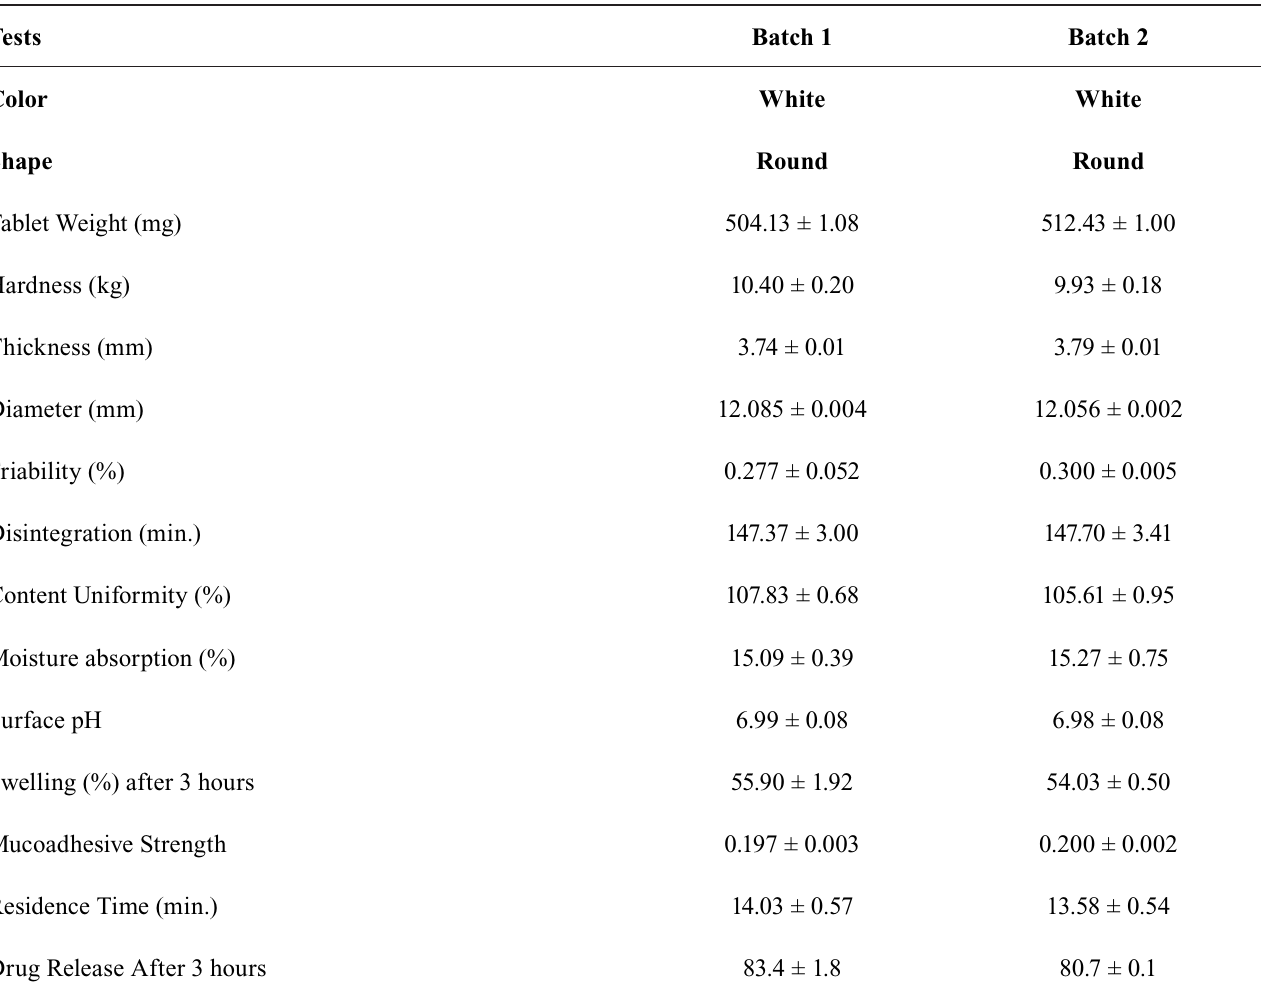
TABLE II - Physicochemical properties of the formulated mucoadhesive buccal tablet of mefenamic